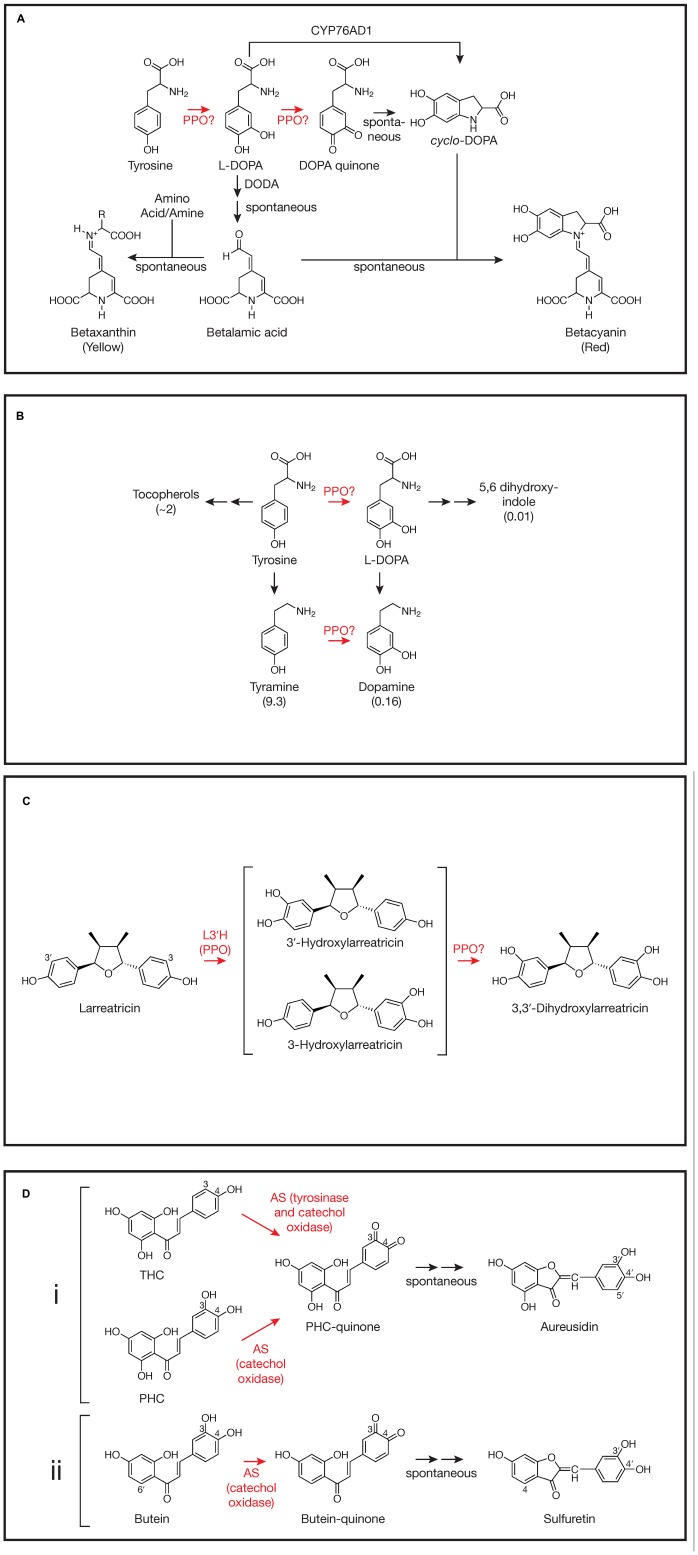
Involvement of polyphenol oxidases (PPOs) in plant specialized metabolism. Steps where PPO involvement has been demonstrated or proposed are highlighted in red. For simplicity, not all reactants, enzymes, or stereochemistry are shown. Steps that occur spontaneously (not mediated by an enzyme) are indicated. (A) Betalain synthesis as described by Hatlestad et al. (2012), Gandia-Herrero and Garcia-Carmona (2013), and others. DODA, DOPA 4,5-dioxygenase; CYP76AD1, the cytochrome P450 described by Hatlestad et al. (2012). The reaction mediated by CYP76AD1 likely proceeds via a DOPA quinone intermediate (Gandia-Herrero and Garcia-Carmona, 2013). (B) Proposed tyrosine metabolism in walnut (Araji et al., 2014). Values in parentheses are fold change in metabolite in walnut plants with PPO silenced via RNAi relative to wild type control plants as reported by Araji et al. (2014). Tyrosine levels did not change and L-DOPA itself was not detectable. (C) 3,3′-Dihydroxylarreatricin biosynthesis in creosote bush as proposed by Cho et al. (2003). L3′H, larreatricin 3′-hydroxylase. (D) (i) Aureusidin biosynthesis in A. majus as proposed by Nakayama et al. (2001). AS, aureusidin synthase (here, a vacuolar PPO); THC, 2′,4′,6′,4-tetrahydroxychalcone; PHC, 2′,4′,6′,3,4-pentahydroxychalcone. For simplicity, bracteatin formation from PHC by AS is not shown. (ii) Sulfuretin biosynthesis in C. grandiflora as proposed by Kaintz et al. (2014). AS, aurone synthase (here, a plastidic PPO).